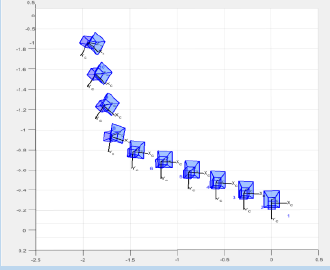
Figure 1. An example of 3D trajectory of a moving sensor generated with visual odometry.